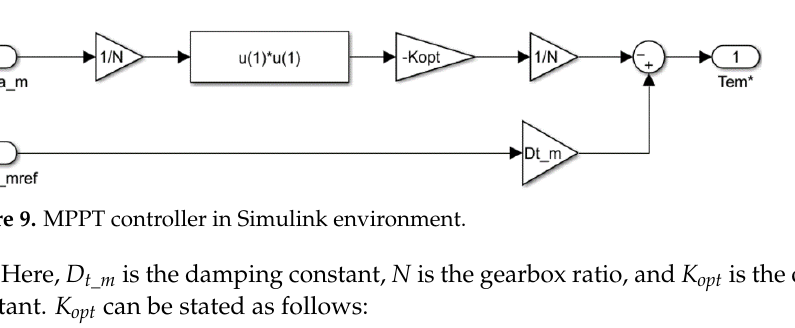
Figure 8. Proposed controller of rotor side converter.